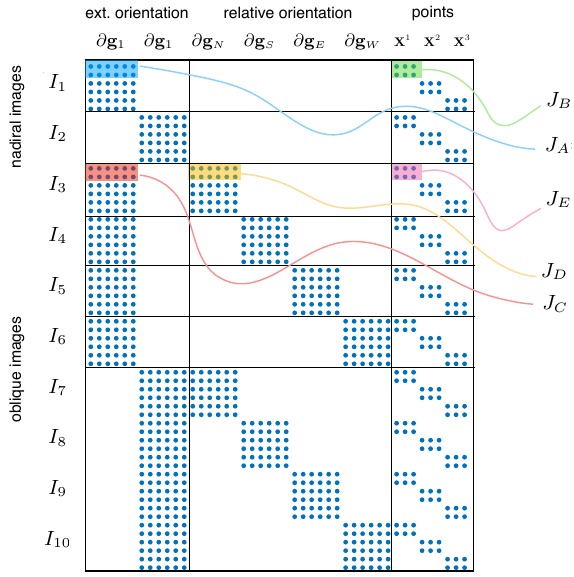
Figure 2. Primary structure of the BBA Jacobian for a block of 2 nadiral cameras, 8 oblique and 3 points